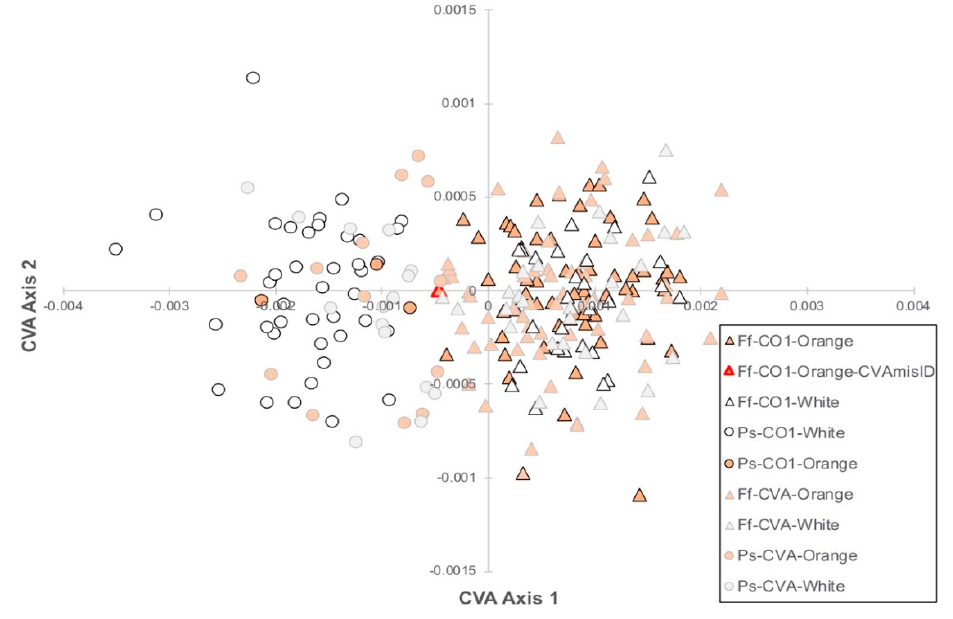
Figure 3. Canonical variates analysis (CVA) biplot of F. flava (Ff) and P. sintoxia (Ps) using 21 landmarks (Figure 1). In the legend, “CO1” refers to specimens that were sequenced at COI and used to build the CVA model and “CVA” refers to specimens were assigned to species using the CVA only (no COI sequence). Foot color is indicated using orange or white markers. Significant di ff erences ( p < 0.0001) in shell shape were found along axis 1.